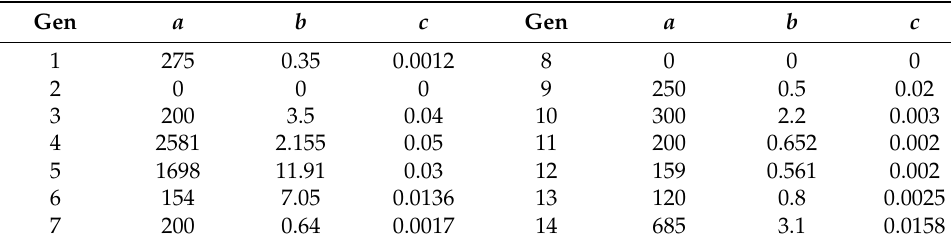
Table A3. The cost coefficients of generators for the ISGHV network.